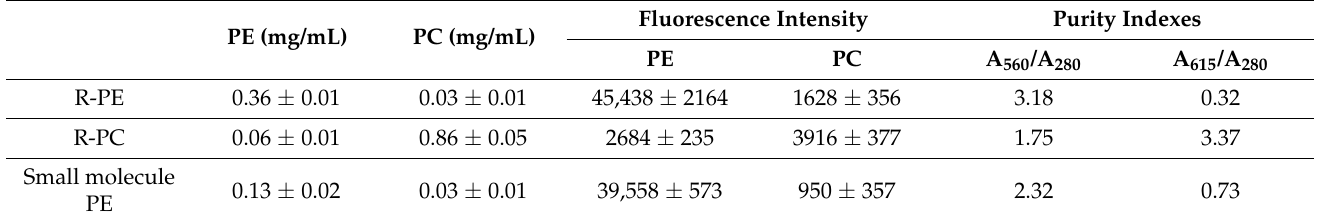
Table 3. FPLC analysis of R-PE, R-PC and small molecule PE fractions.